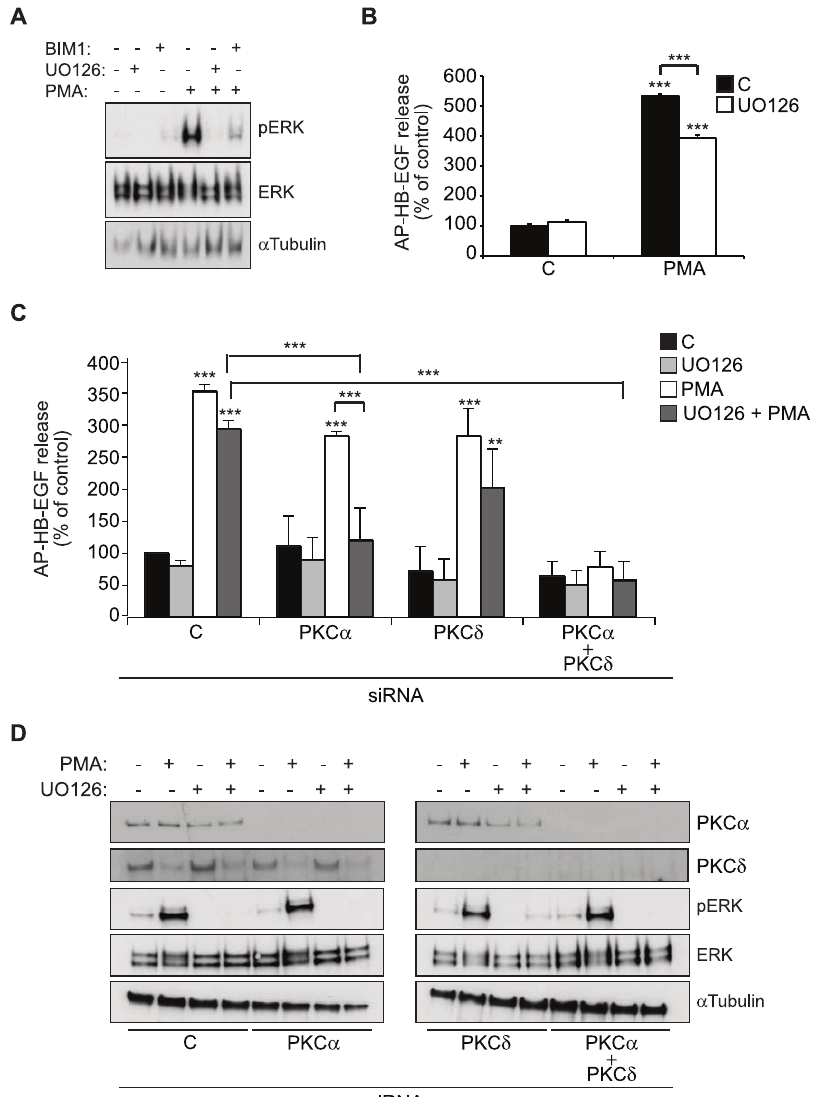
Figure 5. PMA-induced HB-EGF shedding acts through at least two separate mechanisms. A ) Western blot analysis of phospho-ERK and total ERK in total cell extracts from AP-HB-EGF expressing HT1080 cells treated with PMA (400 nM, 30 min) or DMSO control and with the MEK inhibitor UO126 (10 m M), the PKC inhibitior BIM1 (2 m M), or the respective vehicle controls. a -tubulin is used as an internal loading control. B ) AP-HB- EGF release measured as alkaline phosphatase activity (OD 405 nm) in conditioned media from AP-HB-EGF expressing HT1080 cells treated with 400 nM PMA or DMSO control for 30 min and treated with the MEK inhibitor UO126 (10 m M, white bars) or vehicle control (C; black bars). C ) as in B) except that cells were reverse transfected with control (C) or PKC siRNAs as indicated for 72 h before treatment. D ) Western blot analysis of total cell extracts from cells used in C, demonstrating efficient siRNA-mediated knockdown. a -tubulin is used as an internal loading control. All graphs show average values 6 standard error of the mean of at least three independent experiments each done in triplicate. *p , 0.05; **p , 0.01, ***p , 0.001 after one-way analysis of variance with Bonferroni’s post tests for multiple comparisons. Unless otherwise indicated, the comparison is relative to the respective